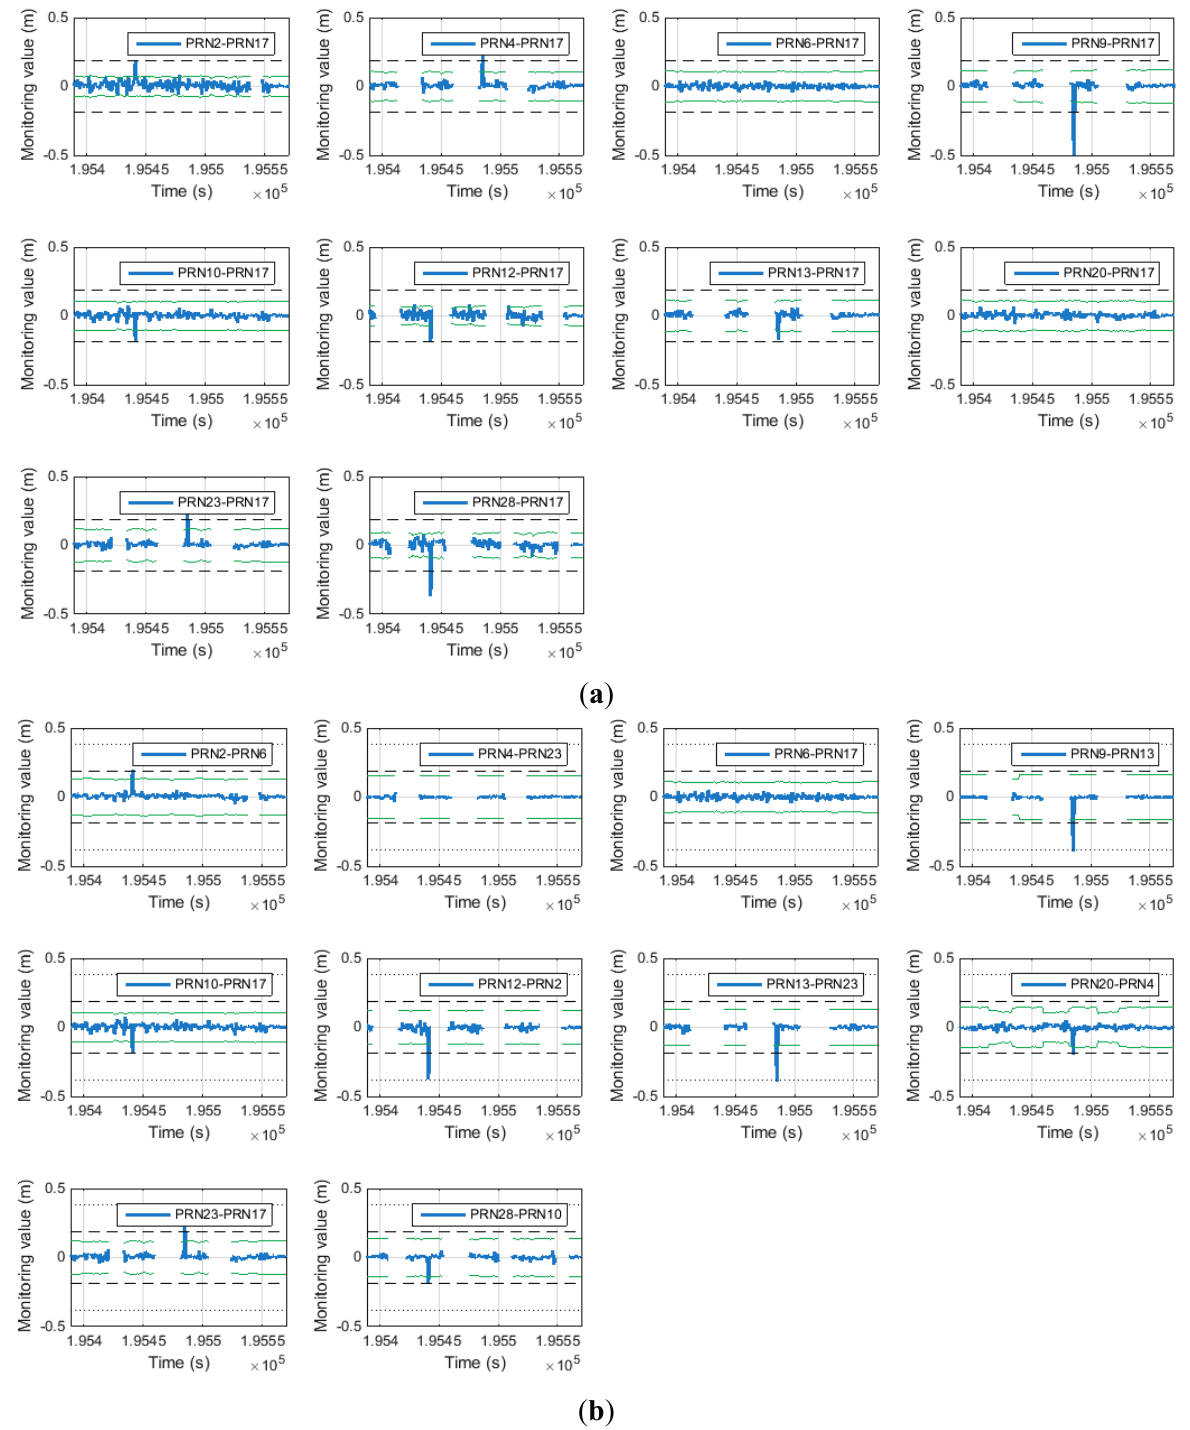
Figure 19. ( a ) Cycle slip detection result of general SD (above); ( b ) cycle slip detection result of proposed SD